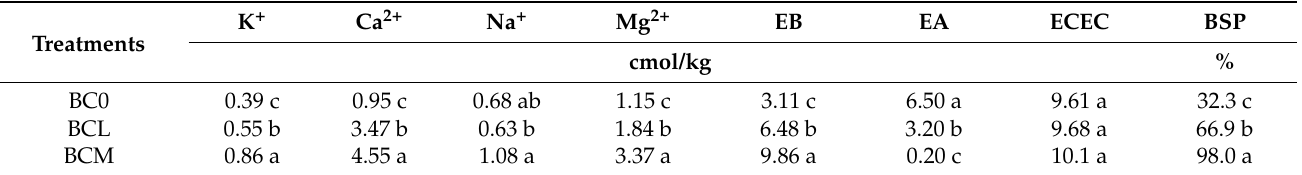
ration percentage in red soil affected by successive application of straw biochar after ten